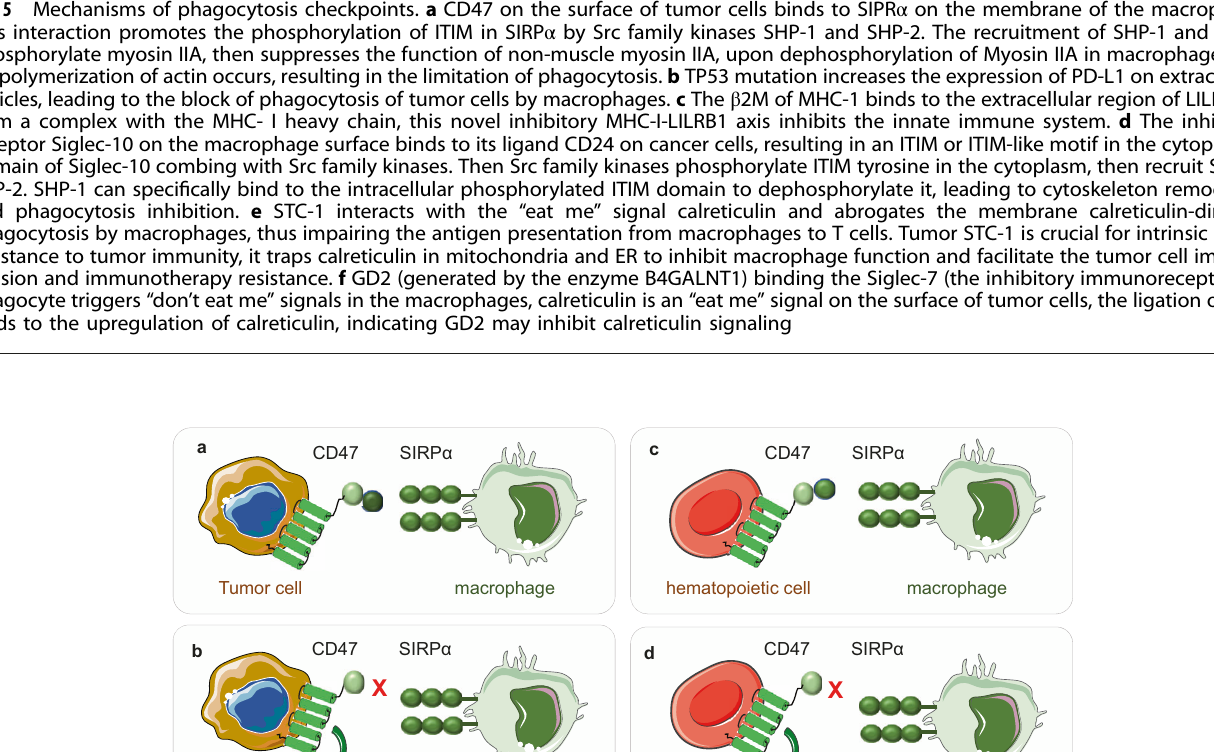
Fig. 6 CD47-SIRP α pathway. a CD47 expressed on tumor cells interacts with SIRP α expressed on macrophages and other phagocytes to avoid immune surveillance. b Targeting CD47 or blocking the CD47-SIRP α axis interrupts their interaction and allows macrophages to phagocyte tumor cells. c CD47 expressed on hematopoietic cells or red blood cells interacts with SIRP α expressed on macrophages and other phagocytes to avoid phagocytosis. d Targeting CD47 or interrupting the CD47-SIRP α axis allows macrophages to phagocyte hematopoietic cells and thus brings the side effects such as anemia